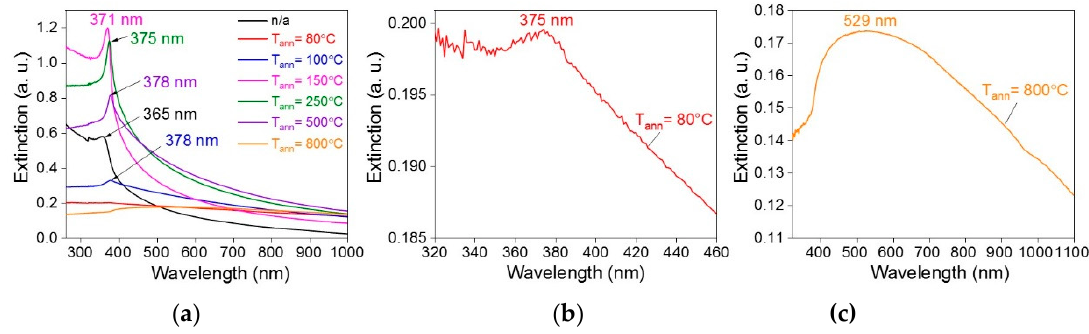
Figure 6. ( a ) UV-Vis absorption spectroscopy of as-prepared ZnO NP before and after annealing, ( b ) zoom in the UV region of the ZnO NP annealed at 80 °C, and ( c ) magnification of the UV-Vis absorption spectra of the ZnO NP annealed at 800 °C.